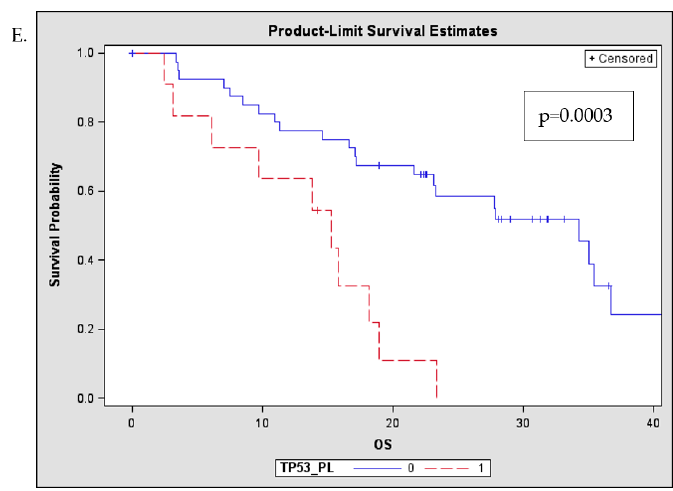
Figure 4. Presence of TP53 mutations in the PL has a significant prognostic implication ( A – C ) OMD: Pie-charts represent the proportion of RAS-RAF and TP53 mutations in BM-specific, PL-specific and shared mutations with a significant change in the proportions between the three populations (Chi-square, * p = 0.0159) ( D ) Kaplan-Meier (Product-Limit) OS plots and log-rank tests to compare RR patients with the presence (1 or more) or absence (0) of TP53 mutations, indicating that TP53 mutational presence either in the BM or PL is a significant prognostic factor ( p = 0.04) ( E ) Patients with 1 or more TP53 mutations in the PL had significantly shorter OS compared to patients with no TP53 mutations in the PL ( p = 0.003) (BM: bone marrow, PL: plasma, OS: overall survival, RR: relapsed/refractory)